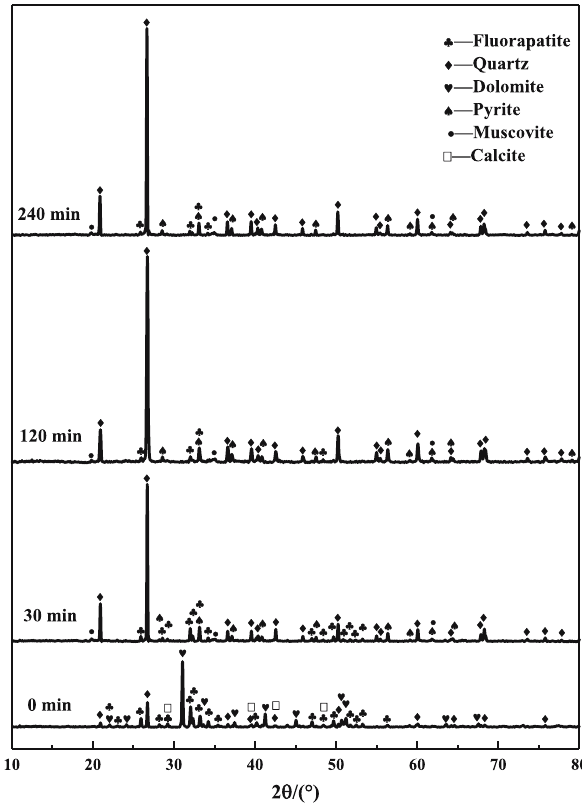
Figure 10: XRD spectrum of phosphate ore after leaching for dif - ferent